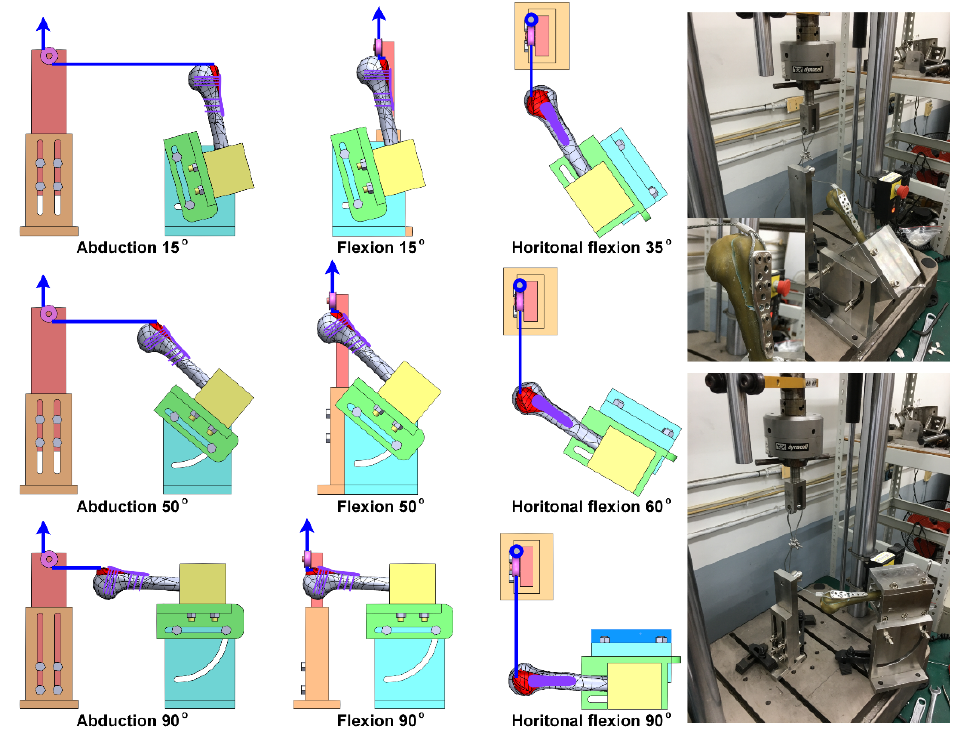
Figure 3. Mechanical test setups for different humerus motions.